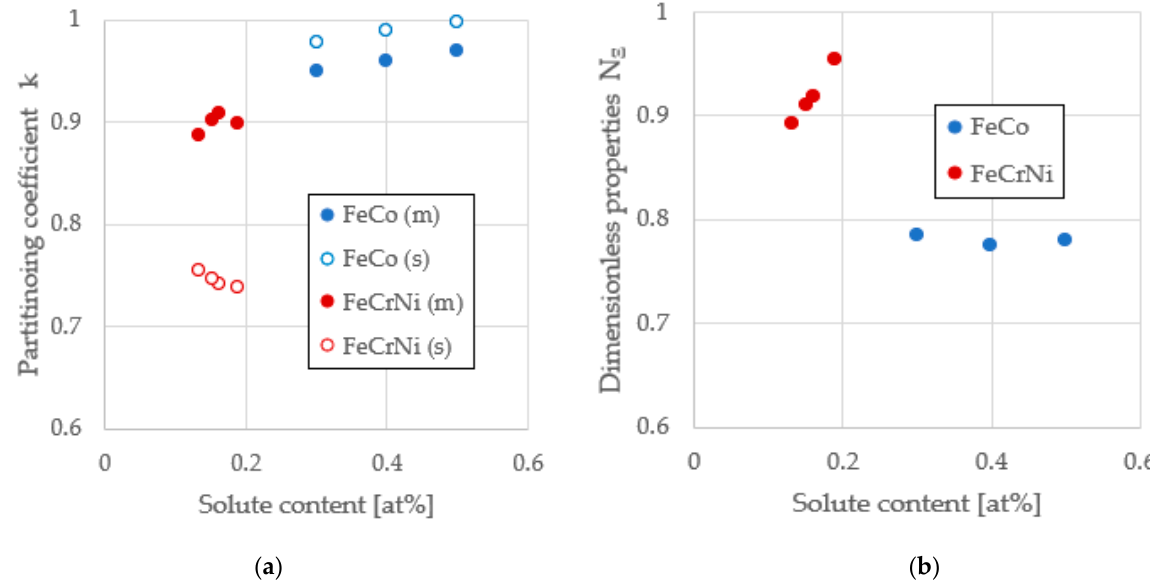
Figure 1. Characterizing key physical properties from Fe-Co and Fe-Cr-Ni alloy systems. ( a ) Dimensionless partitioning coefficient k = C S /C L for metastable (m) and stable (s) solid phases; for FeCrNi, the metastable bcc phase rejects Ni and the stable fcc phase rejects Cr; for FeCo, both metastable and stable phases reject the solute Co; ( b ) dimensionless property parameter N Ξ .